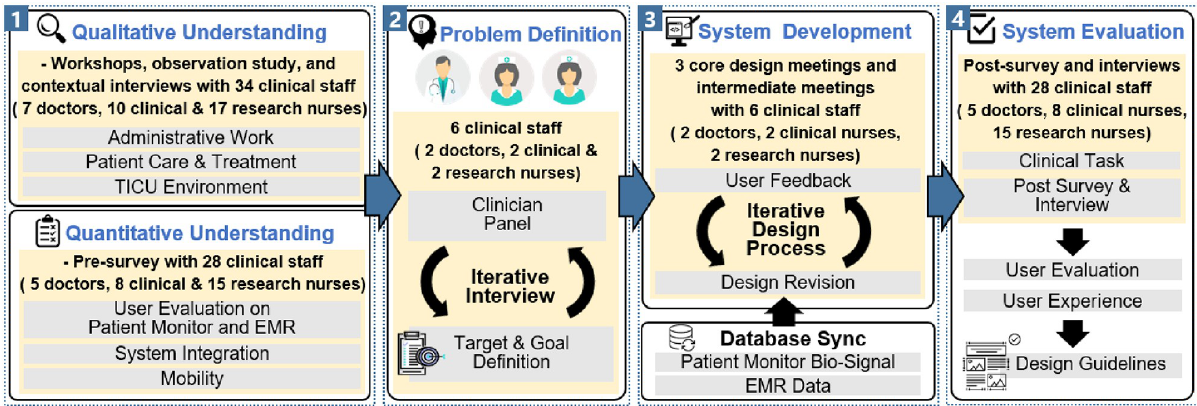
Fig 2. The overall workflow of our study, consisting of (1) the understanding of the TICU work environment (through qualitative and quantitative studies), (2) problem definition, (3) system development, and (4) system evaluation steps.